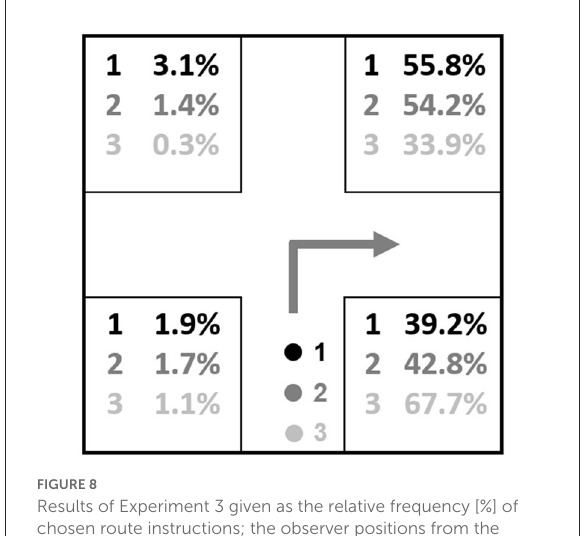
FIGURE8 Results of Experiment 3 given as the relative frequency [%] of chosen route instructions; the observer positions from the intersection are “near” (1), “medium far” (2), and “far” (3); the landmark positions are: “side of the turn, before the intersection” [ (bottom right) ; M ∼ 48.9%]; “side of the turn, behind the intersection” [ (top right) ; M ∼ 48.0%]; “opposite side of the turn, behind the intersection” [ (top left) ; M ∼ 1.6%]; “opposite side of the turn, before the intersection” [ (bottom left) ; M ∼